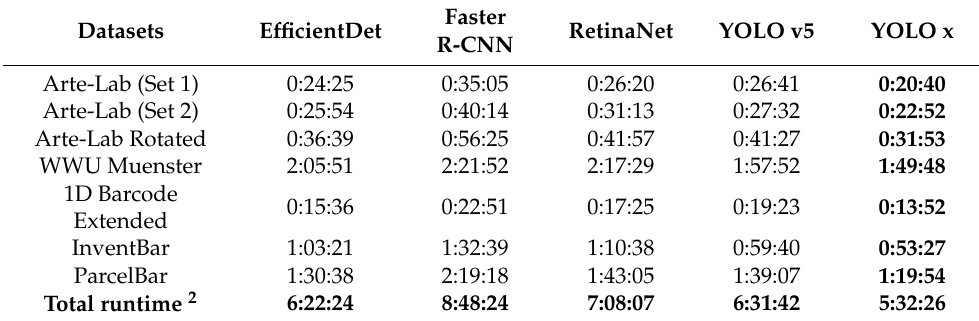
Table 8. Average runtime performances of D-CNN methods applied over seven public bar- code